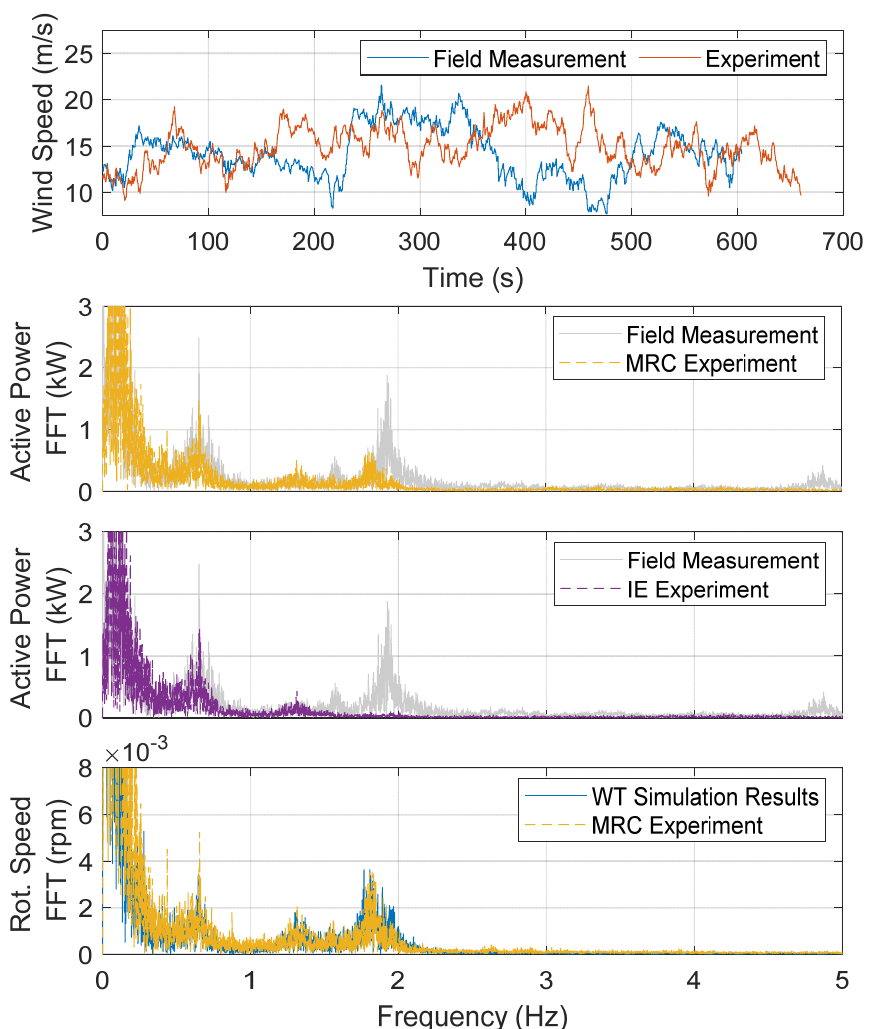
Figure 8. Frequency analysis of the active power output during normal operation of the DUT in the field and at the test bench.